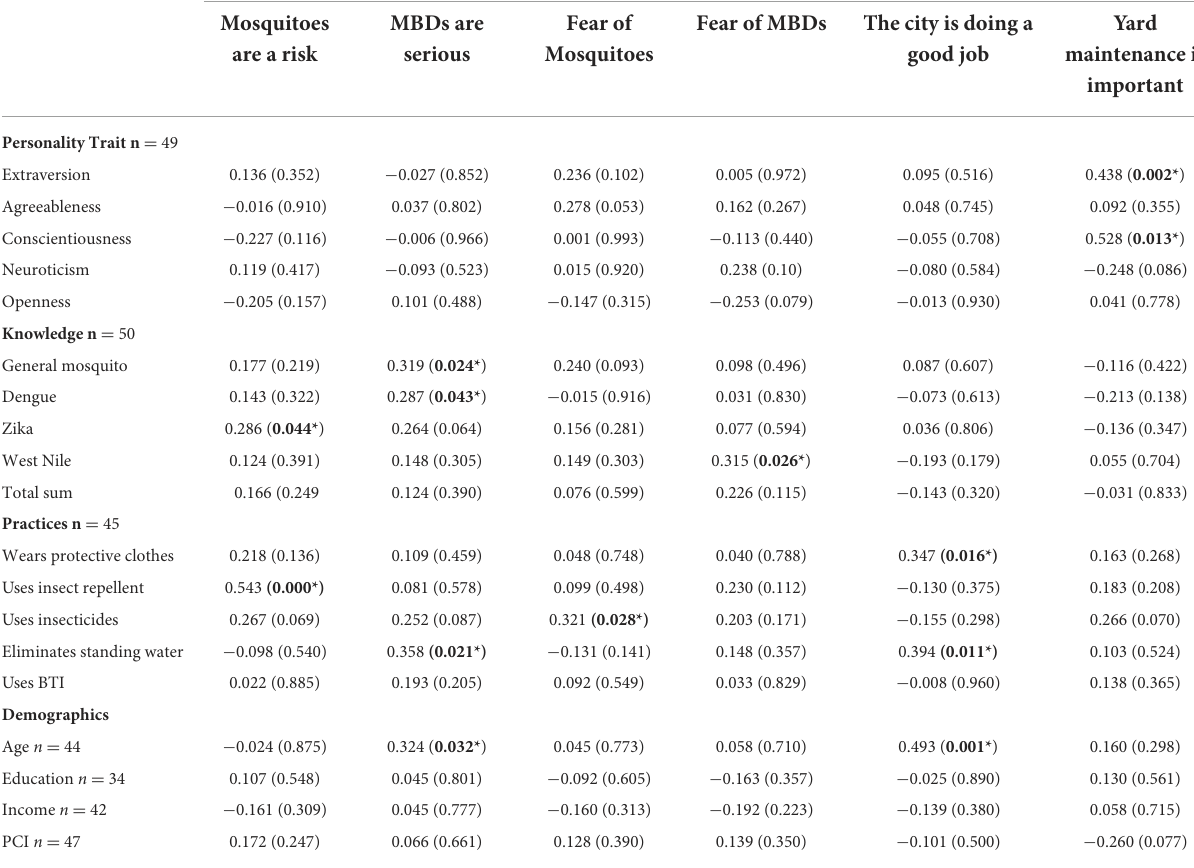
TABLE 5 Correlations between attitudes and personalities, knowledge, practices, and